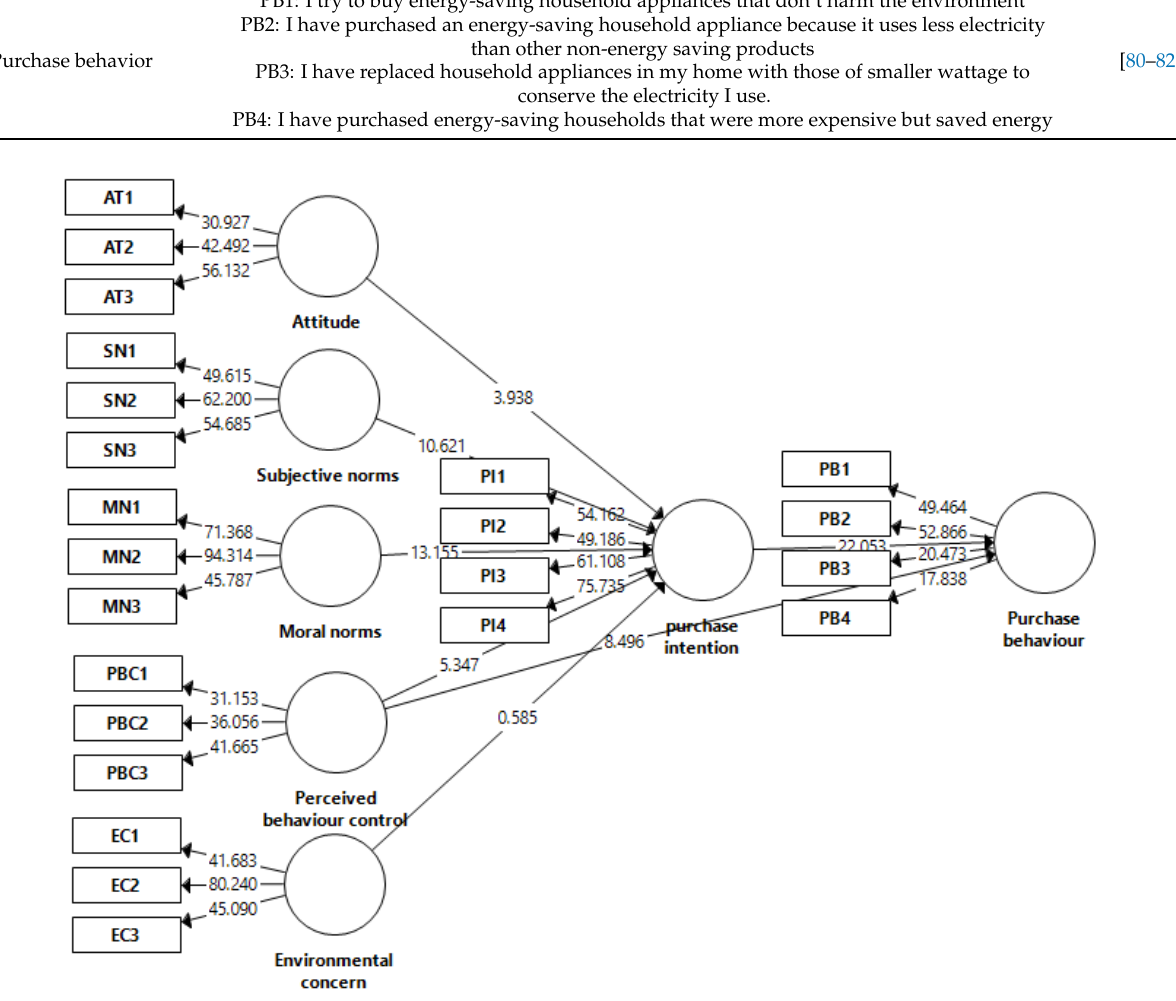
Figure A1. empirical research model based on TPB (results of the path coefficient)